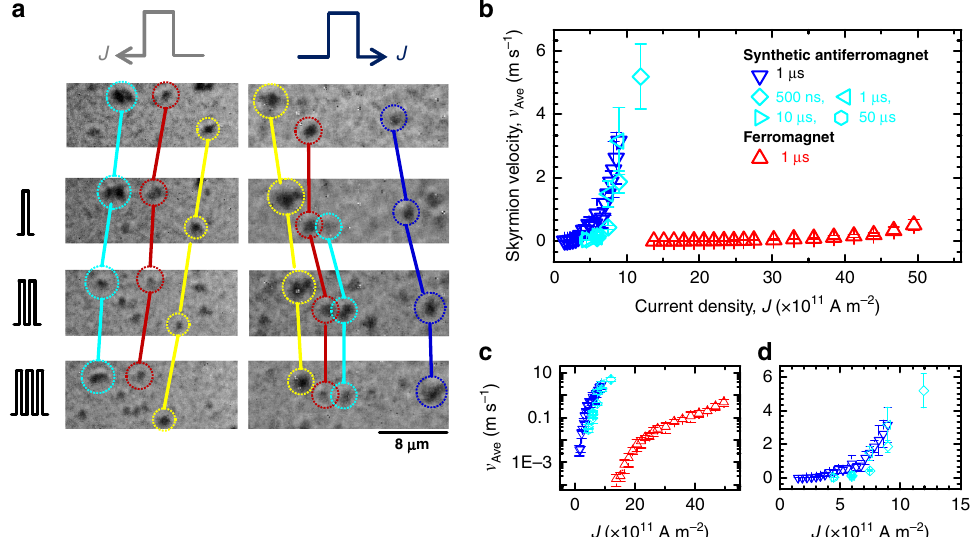
Fig. 2 Current-induced motion of synthetic antiferromagnetic skyrmion bubbles. a Magnetic state of synthetic antiferromagnetically coupled wire obtained with magneto-optical polar Kerr effect microscopy under current pulse applications at μ 0 H z = 0.2 mT. Each skyrmion is featured by different colors. Current density and pulse width are 7.1 × 10 11 A m − 2 and 1 μ s, respectively. b Current density dependence of average velocity of skyrmion bubbles in stacks 1 (synthetic antiferromagnet) and 2 (ferromagnet), represented by blue and red, respectively. For stack 1, results with various pulse widths are plotted by different symbols. c The same result shown by a logarithm scale for vertical axis. d The same result focused in a low-current-density